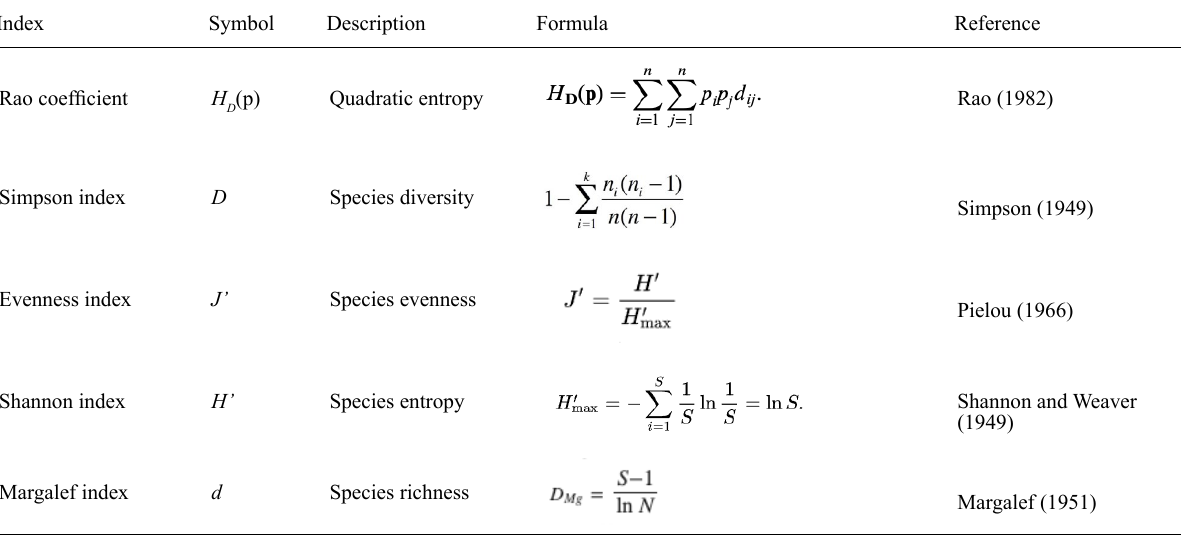
1. – List of some quantitative indices to measure functional and taxonomic